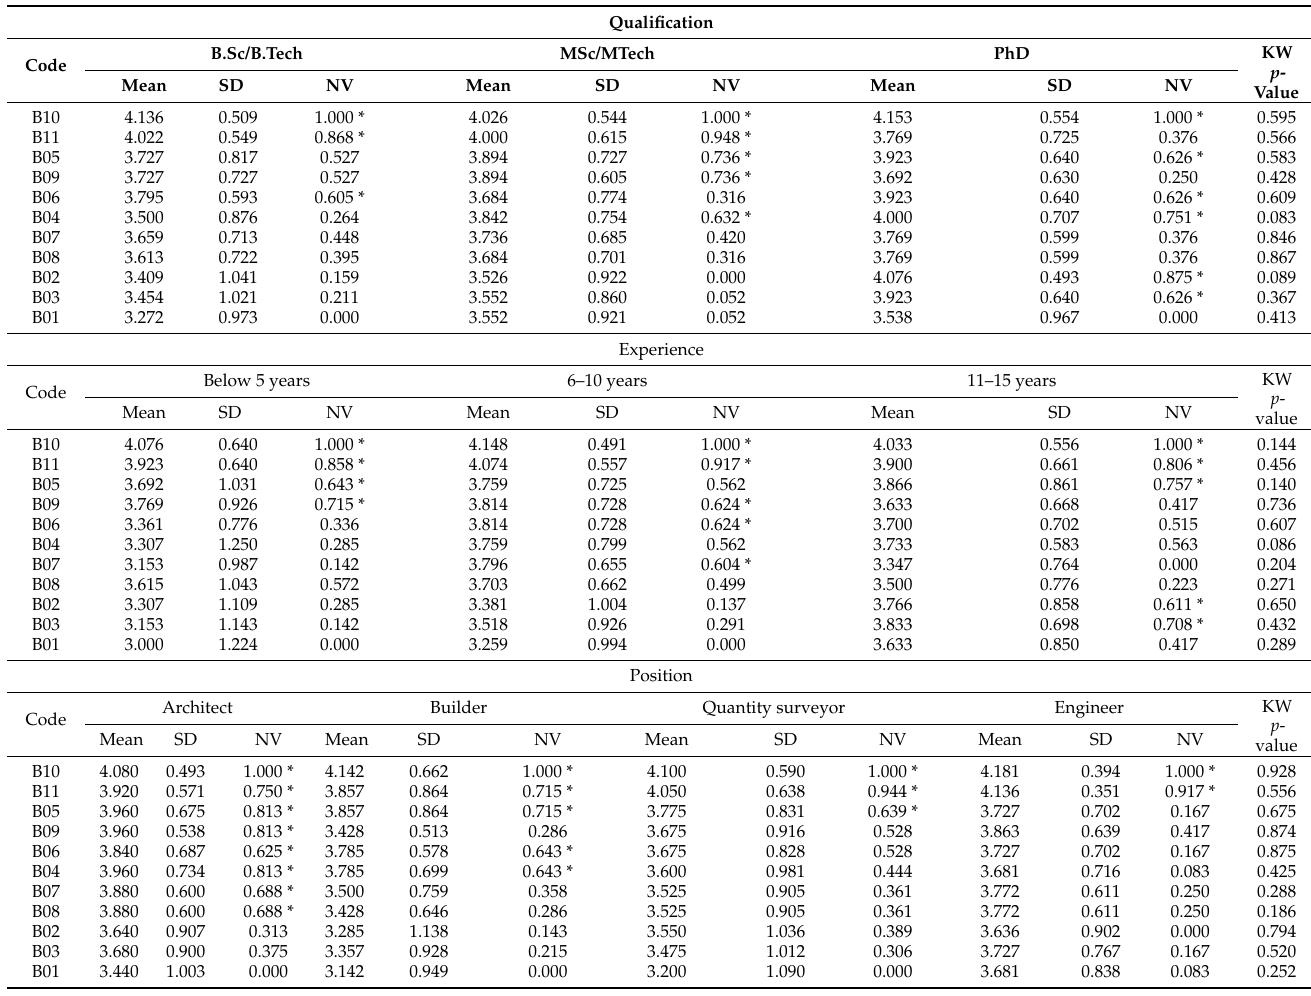
Table 4. Results of the summary of comparison and agreement